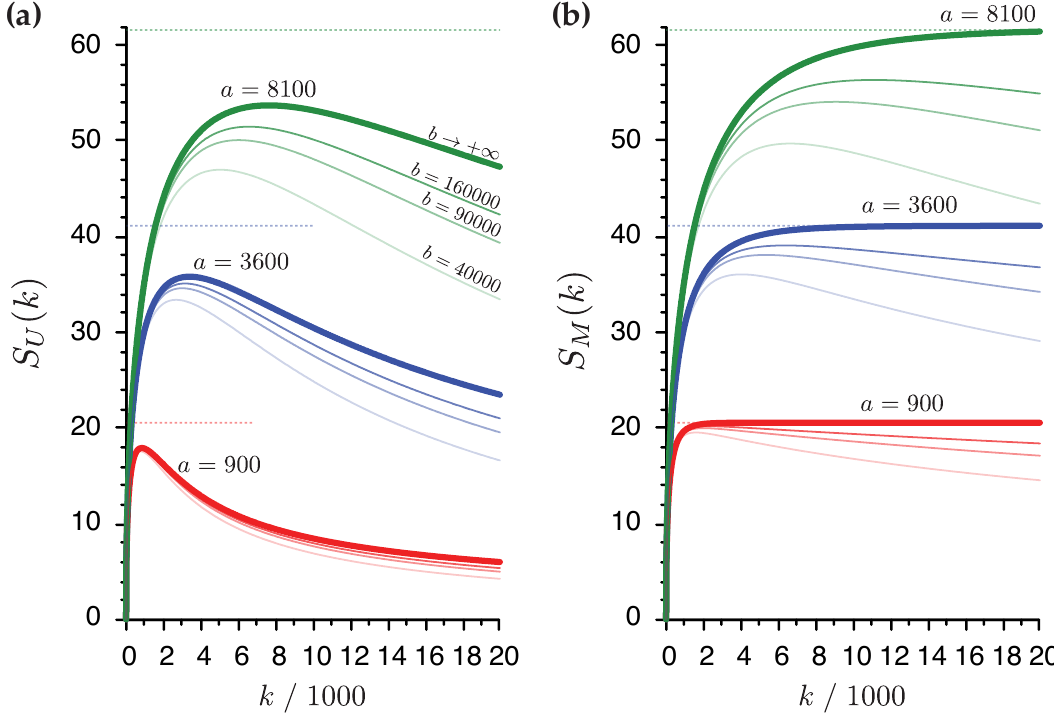
Figure 3. Sensitivity enhancement by the CPMG NMR experiment plotted against the number of echoes acquired, k , using ( a ) the unweighted sensitivity function S U ( k ) ( b ) the matched sensitivity S M ( k ) . Three families are distinguished on the basis of the value of a = T CPMG / τ : a = 900 (red), a = 3600 (blue), a = 8100 (green). Four branches are plotted for each family corresponding to different values of b = τ rd / τ : b = 40,000, b = 90,000, b = 160,000, and b → + ∞ , in order of increasing opacity. The lines in bold stroke correspond to Equations (5) or (6). The dashed lines indicate the asymptotic value of G M ( k ) for the corresponding value of a . The values of β = 2 , j 0 = 1, and l = 0 are common to 3 all curves